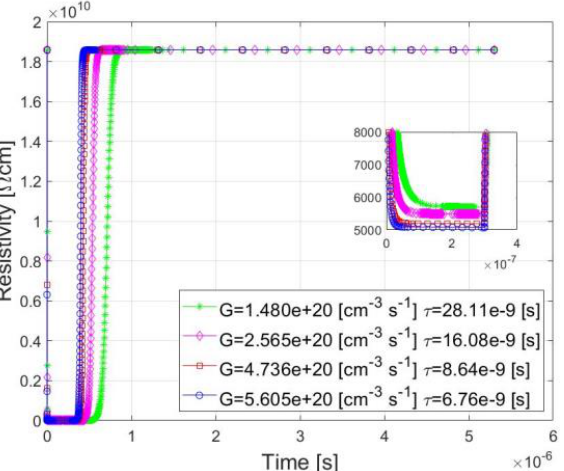
Figure 4. Changes in material resistivity over time for the generation coefficient values corresponding to the results of experimental tests of the GaP-1 sample. The inset shows an approximation of the first 400 ns. At time zero, the lighting of the sample is turned on. Measurements carried out at a temperature of 300 K.